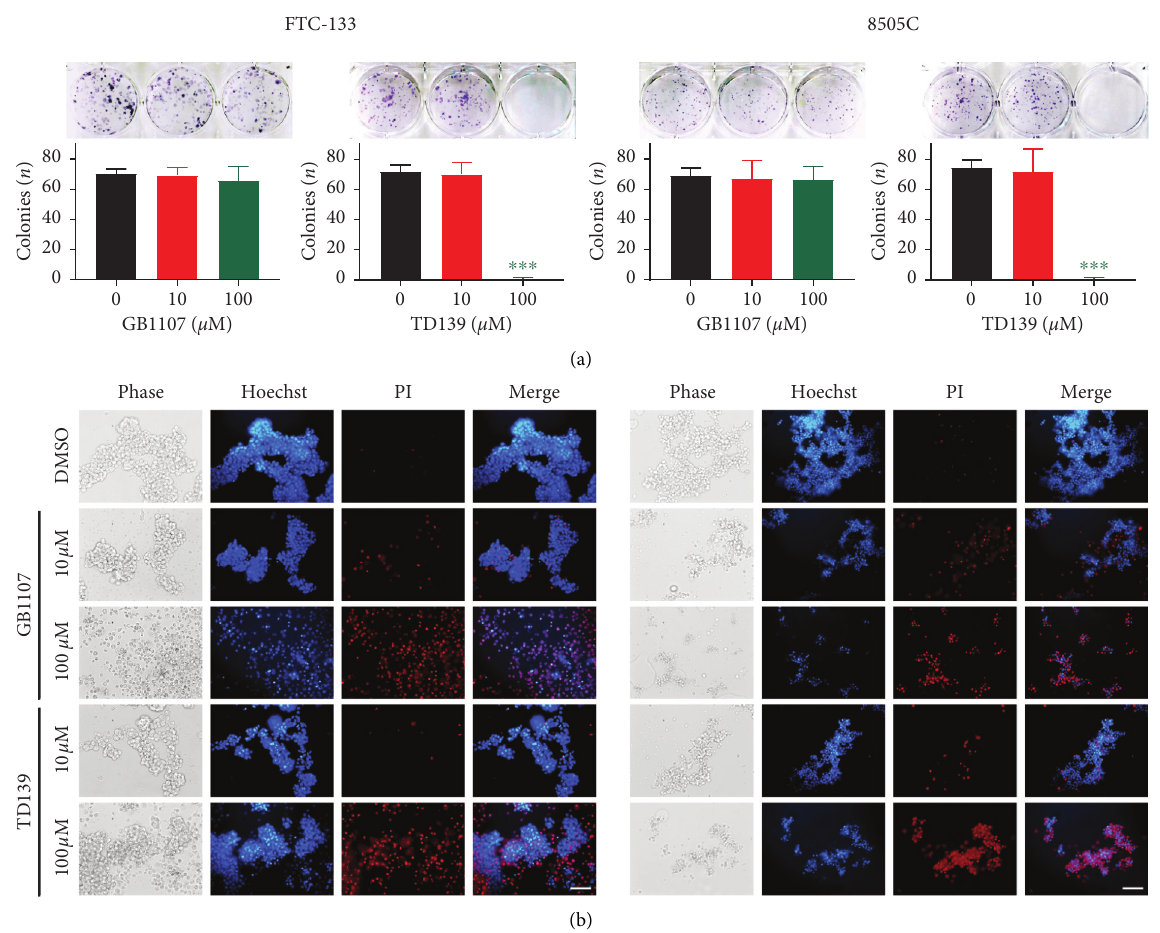
Figure 3: Effects of galectin-3 inhibitors (GB1107 and TD139) on clonogenicity and anoikis resistance in FTC-133 and 8505C human thyroid cancer cells. (a) Cells treated with GB1107 or TD139 were subjected to clonogenic assay. (b) Cells grown on poly-HEMA-coated plates were treated with GB1107 or TD139 for 48h and stained with Hoechst 33342 and propidium iodide (PI). Scale bars, 100 μ m. ∗∗∗ p < 0 . 001.